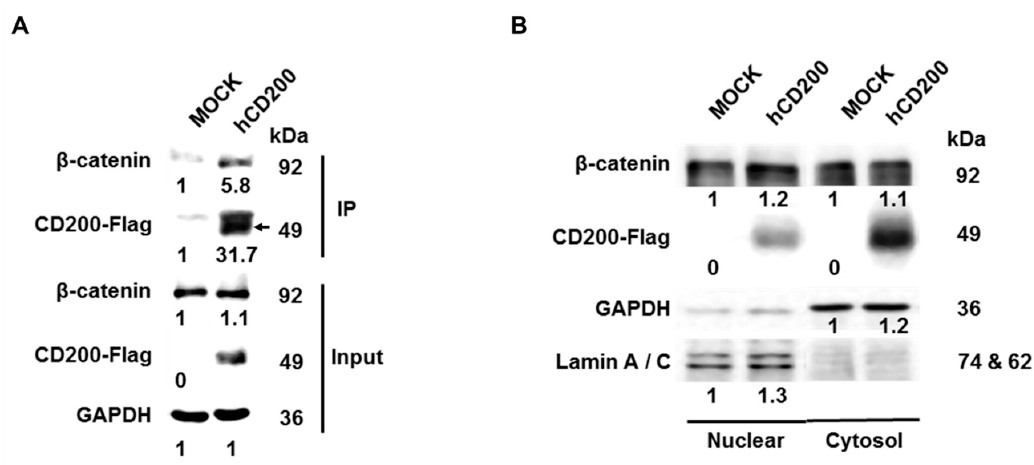
Figure 4. Figure 4. Cont .